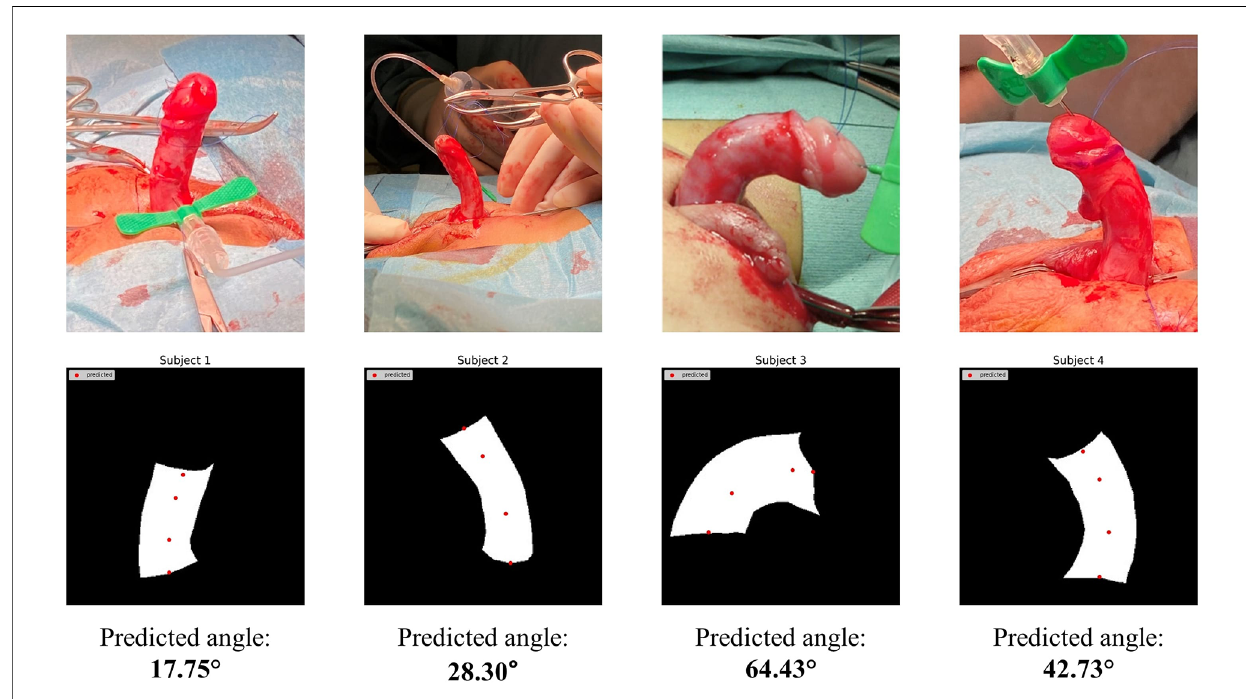
FIGURE 9 HRNet key-point detection results using masks manually extracted from real patient